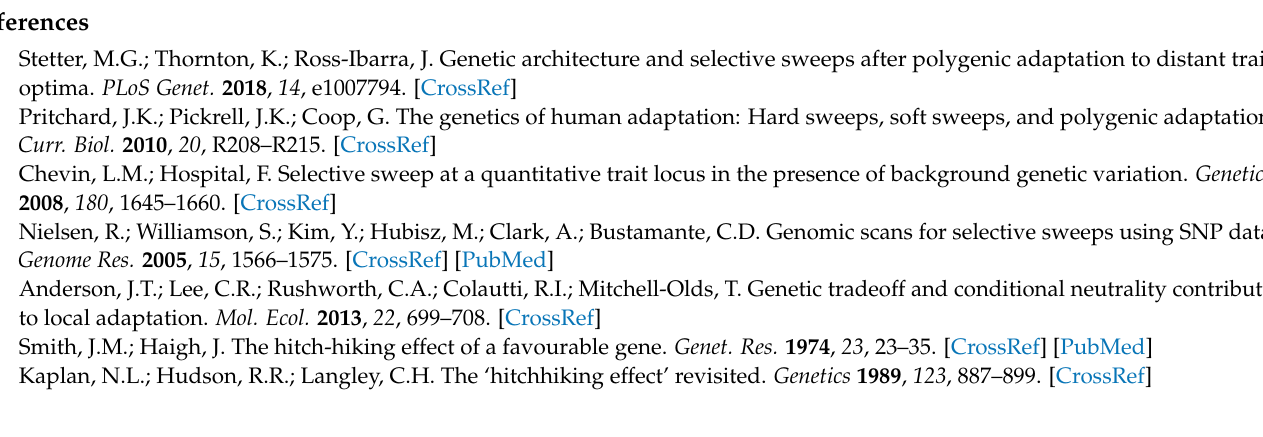
shared significant SNP markers between RDA and LFMM GEA analyses in SEGI (a) and SESE (b), Figure S8: GO enrichment analysis of biological processes in SEGI, Figure S9: GO enrichment analysis of molecular function in SEGI, Figure S10: GO enrichment analysis of biological process (bp) in SESE, Figure S11: GO enrichment analysis of molecular function (mf) in SESE, Table S1: SNPs statistics before and after imputation for giant sequoia individuals, Table S2: SNPs statistics before and after imputation for coast redwood individuals, Table S3: Genomic location of selective sweeps in the genome of giant sequoia identified by non-overlapping sliding windows, Table S4: Genomic location of selective sweeps in the genome of coast redwood identified by non-overlapping sliding windows, Table S5: Total numbers of candidate SNPs in giant sequoia identified by RDA and LFMM methods, Table S6: Total numbers of candidate SNPs in coast redwood identified by RDA and LFMM methods, Table S7: Significant SNPs shared among GEA methods in coast redwood, Table S8: Functional annotation of candidate genes associated with different environmental variables in giant sequoia, Table S9: Functional annotation of candidate genes associated with different environmental variables in coast redwood, Table S10: GO enrichment analysis for BP, MF and CC in SEGI, and Table S11: GO enrichment analysis for BP, MF and CC in